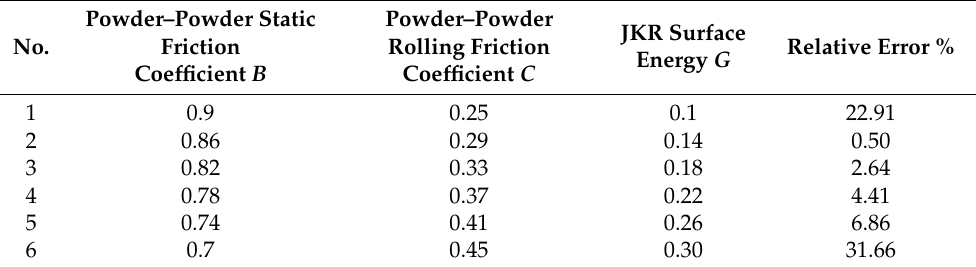
Table 8. The design scheme and results of the steepest climbing